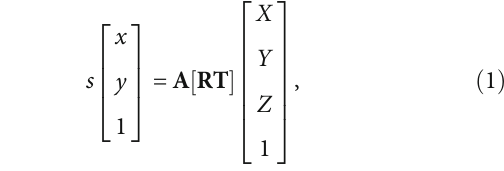
Figure 10: General data processing